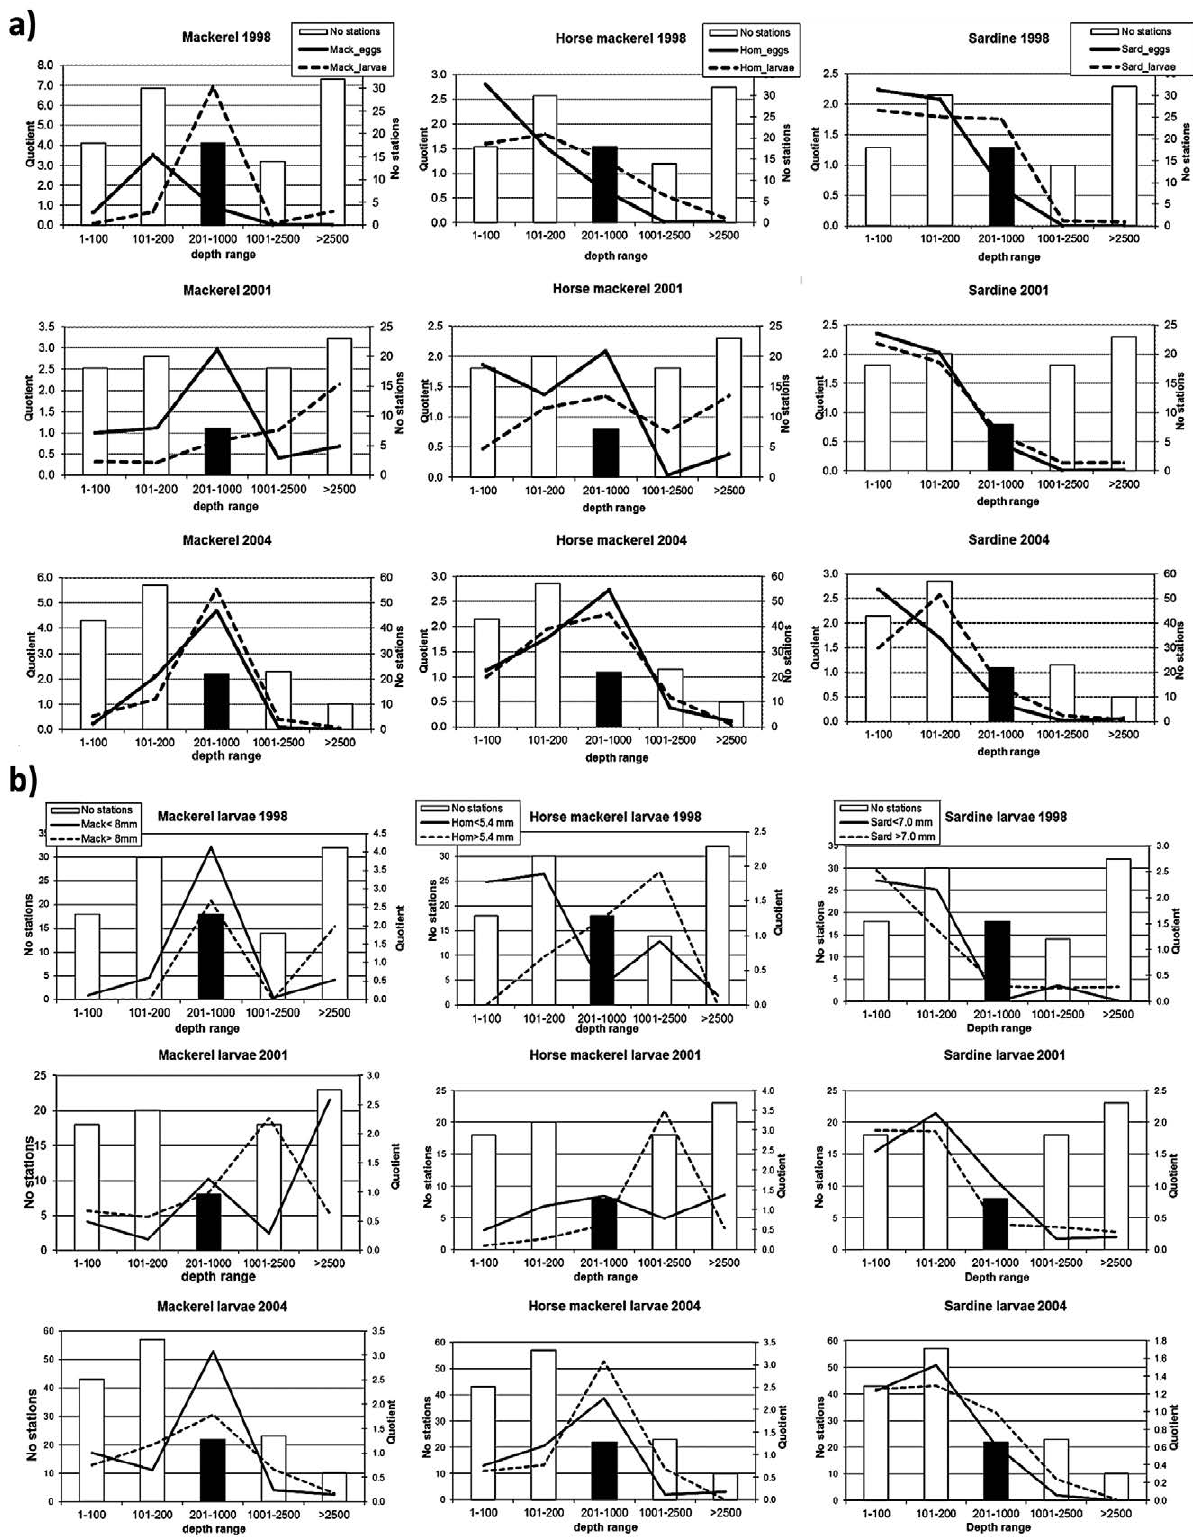
f ig . 2. – Quotient lines of: (a) each species egg and larval abundance and (b) each species larval size abundance with respect to water depth (solid and dashed lines, respectively). The vertical bars indicate the number of samples collected within each water depth class. Black bar represents the shelf